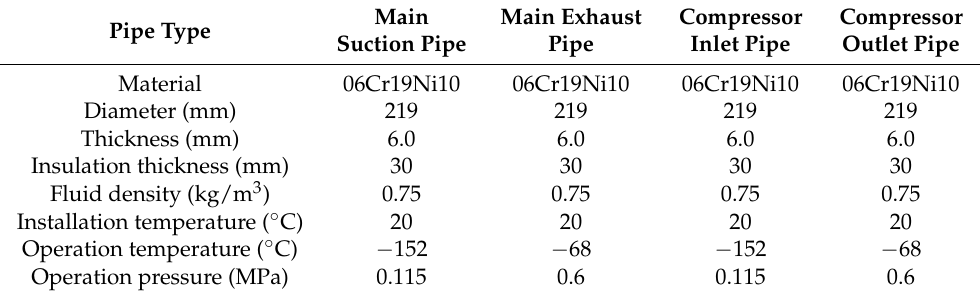
Figure 7. The model of valve seat. In the LNG vaporizing station, four-directional guide are usually used to constrain the displacement of the pipeline. The four-directional guide can better control the reso- nance, and it also needs to define the friction coefficient. In addition, the size of the gap can be defined. When the installation is completed, there is no contact between the pipe and the support, which is a passive constraint. However, when the pipe is thermally dis- placed, the gap between the two can be closed to become an active constraint. The gap